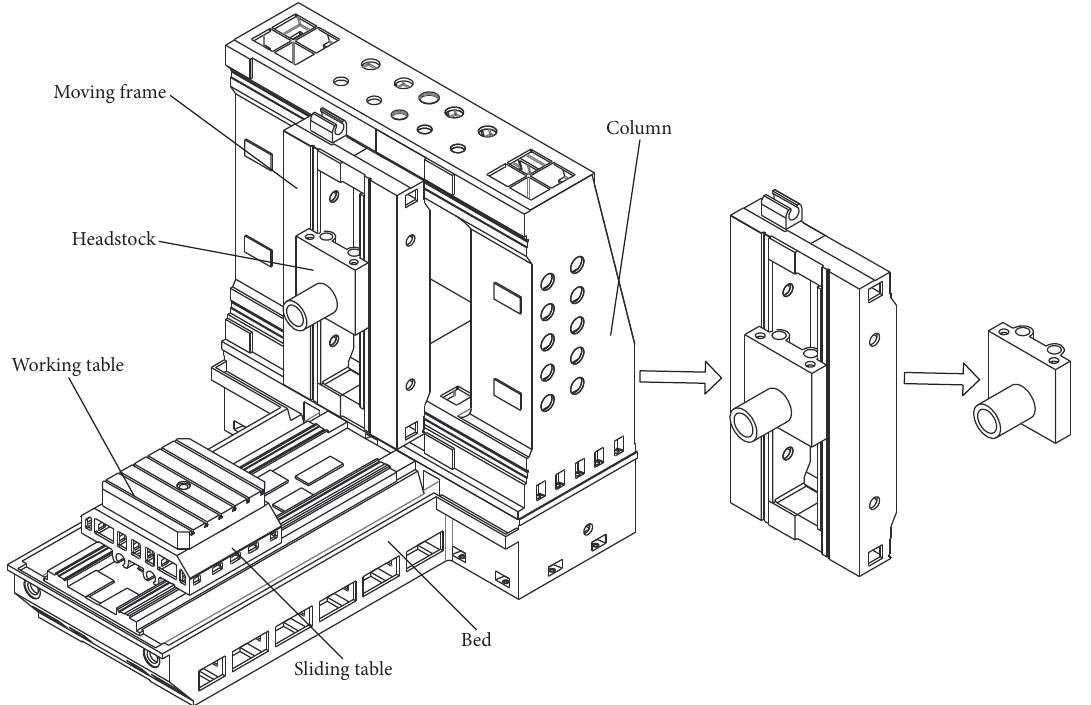
Figure 1: Configuration of a high speed precision horizontal machining